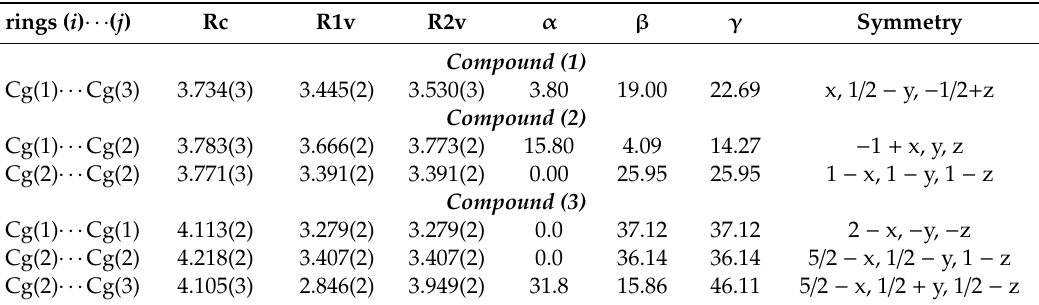
Table 5. Parameters (Å, ◦ ) for π -stacking interactions.